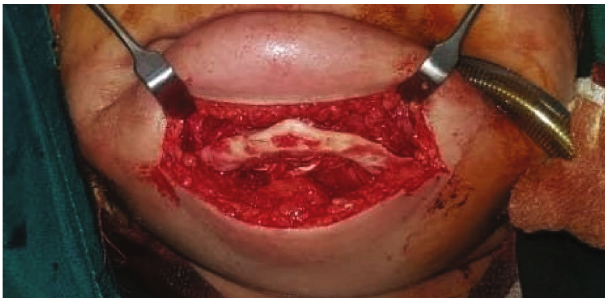
Figure 1: Severely atrophied mandible (mandibular width of 4mm); genioglossus and geniohyoid muscles were not detached.